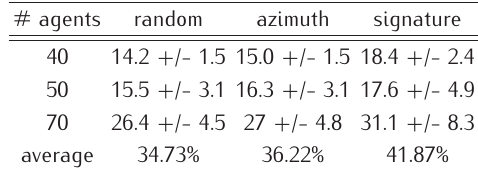
Table 2. Influence of the imitation strategy on the survival rate of the popula- tions. Average number (and standard deviation) of surviving agents. The much higher standard deviation for signature-based imitation is due to some global group